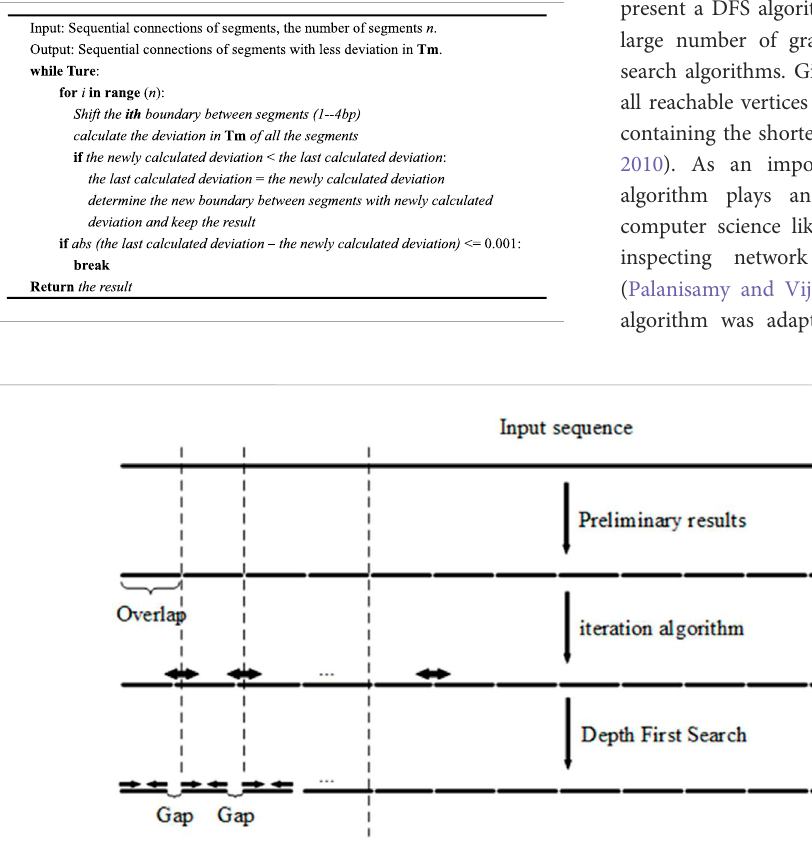
FIGURE 3 Depth- fi rst search algorithm takes the results from the iteration algorithm, shrinks each end of an overlap, and produces a gap between segments. This reduces the standard deviation of the overlap melting